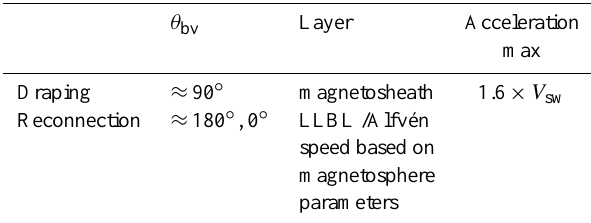
Table 1. Some important parameters that distinguish between draping- and reconnection-related ion accelerations in the GSM equatorial plane. θ bv is the angle between the local B and V vec- tors. V sw is the speed of the solar